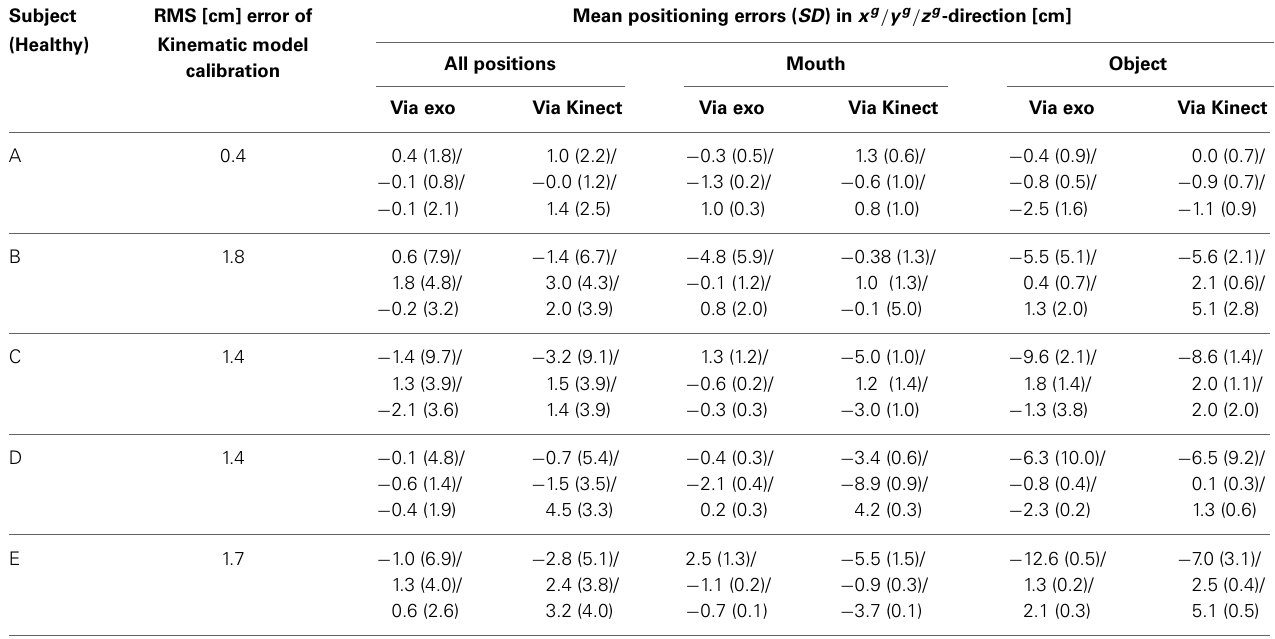
Table 2 | Mean positioning errors along with their standard deviations in x g / y g / z g -direction for five drinking task sequences per subject measured via the exoskeleton sensors and via Kinect.